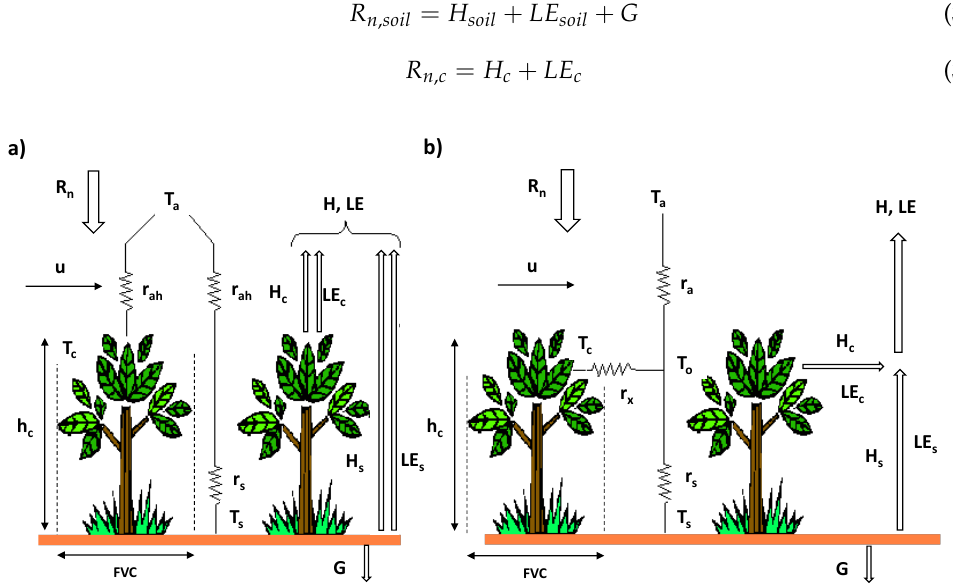
Figure 3. Schematic diagram illustrating resistance network and key input/output parameters and variables for the: ( a ) ‘Parallel’ and ( b ) Series configuration (adapted from [43]).